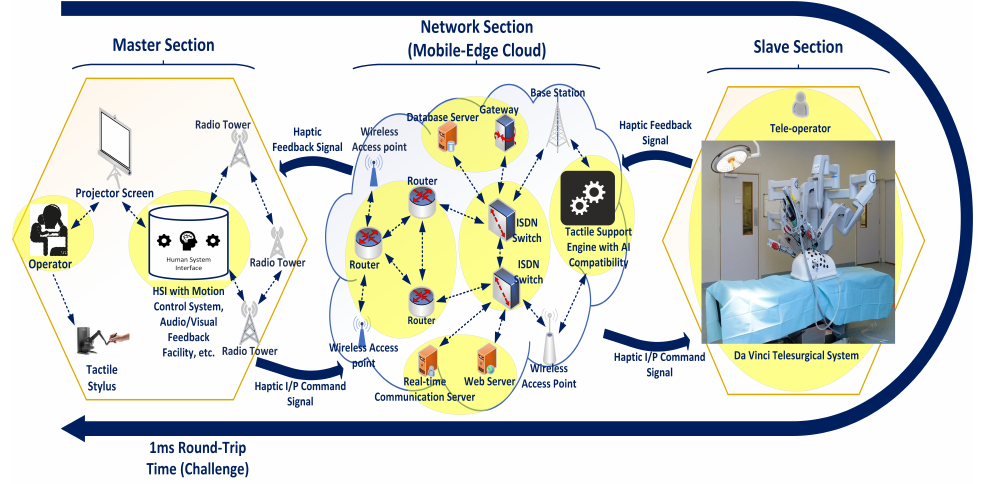
Figure 3. The design architecture for the end-to-end da Vinci telesurgical